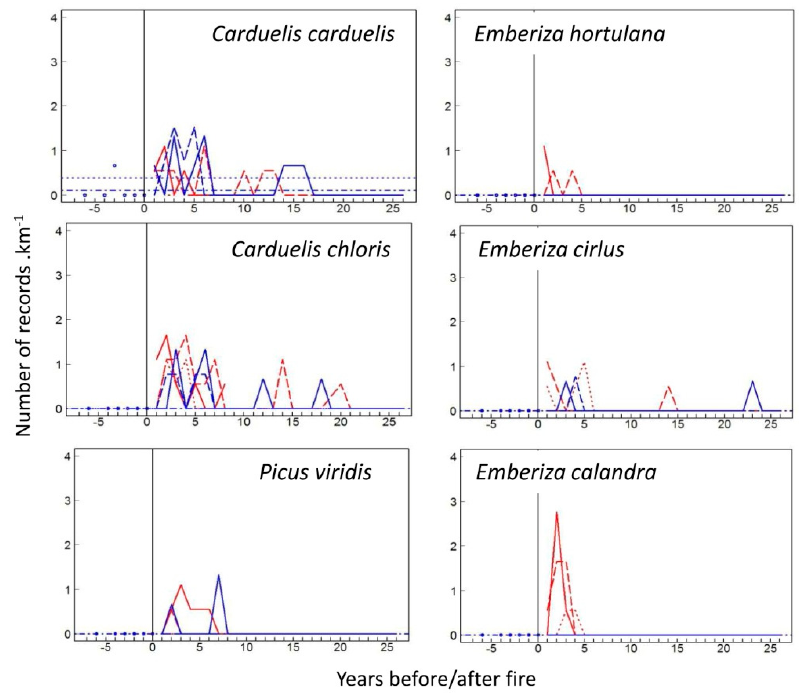
Figure A3. Postfire response curves of six open-habitat bird species; x -axis: years since the last fire; y -axis: number of individuals · km − 1 . In red: transect C; in blue: transect L. Solid line: first fire; dashed line: second fire; dotted line: third fire. Circles (and dash-dotted line): prefire control (and mean ±